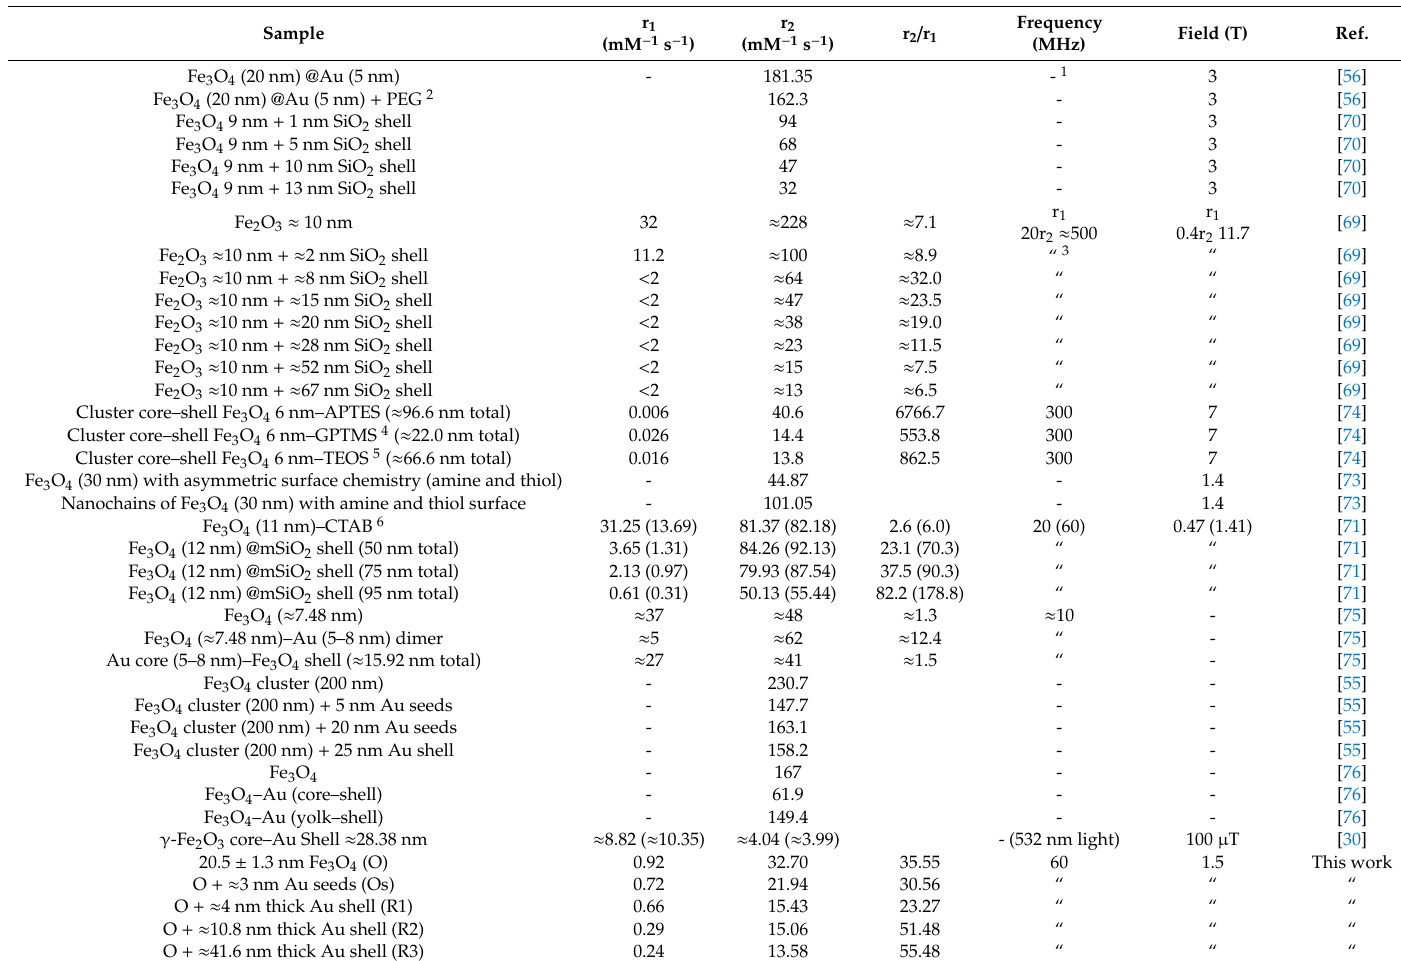
Table 2. Relaxation properties of select examples from the literature, including SiO 2 shells of varied thicknesses and magnetically assembled structures. Relaxation properties of the magnetic-plasmonic nanoparticles studied in this work are shown in the last 5